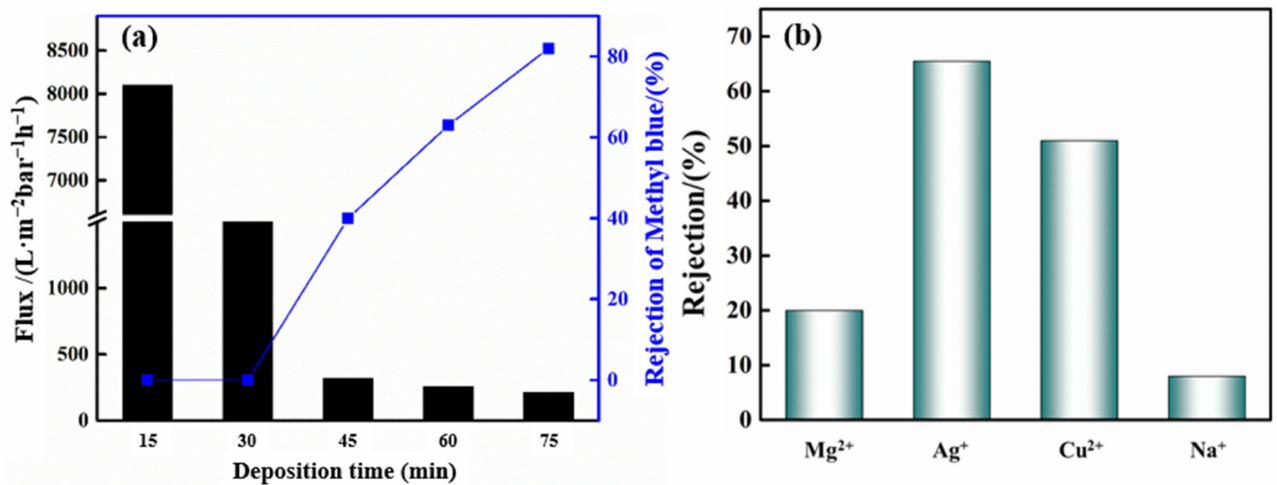
Figure 8. Effect of ZrO 2 surface layer deposition time on pure water flux and methyl blue interception of the ZTA composite membrane ( a ), Ag + , Cu 2+ , Mg 2+ , Na + cationic interception effect of ZTA membrane after 75 min deposition ( b